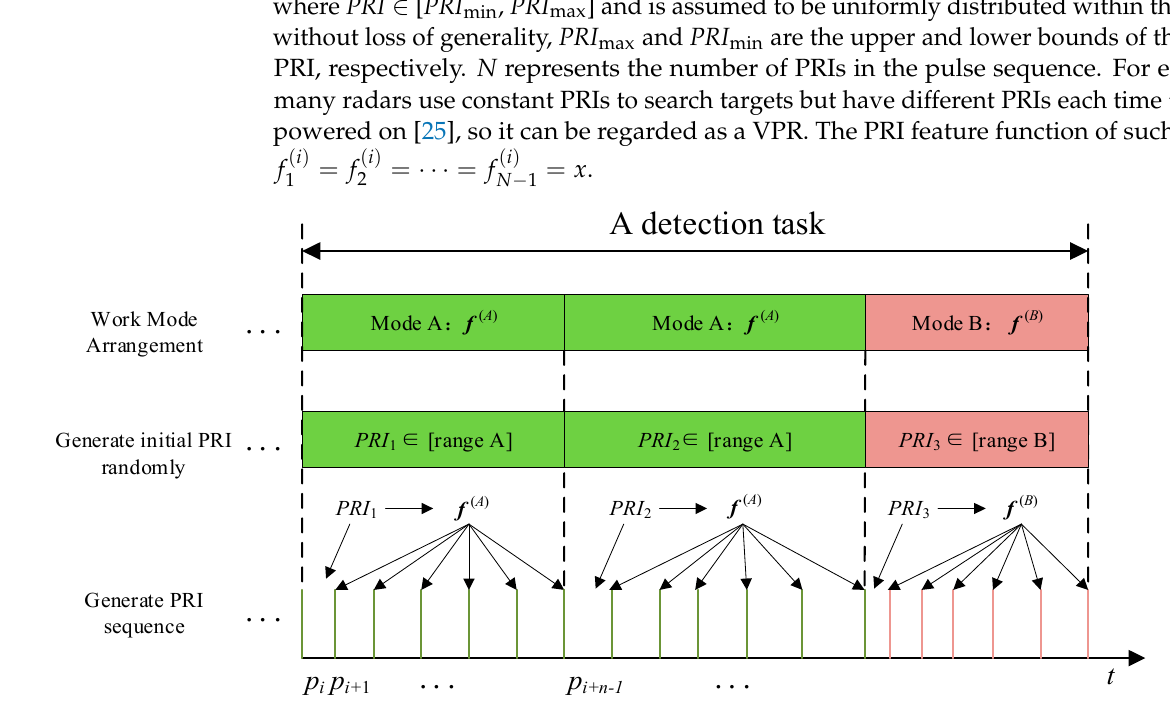
Figure 1. Schematic diagram of pulse train generated by variable parameter radar.